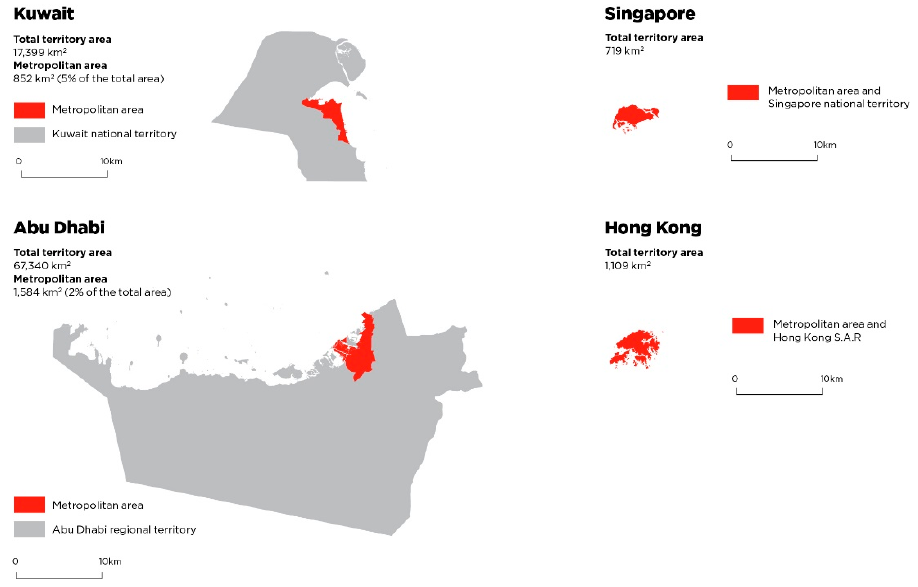
Figure 2. Case study territories/countries and metropolitan areas at the same scale.